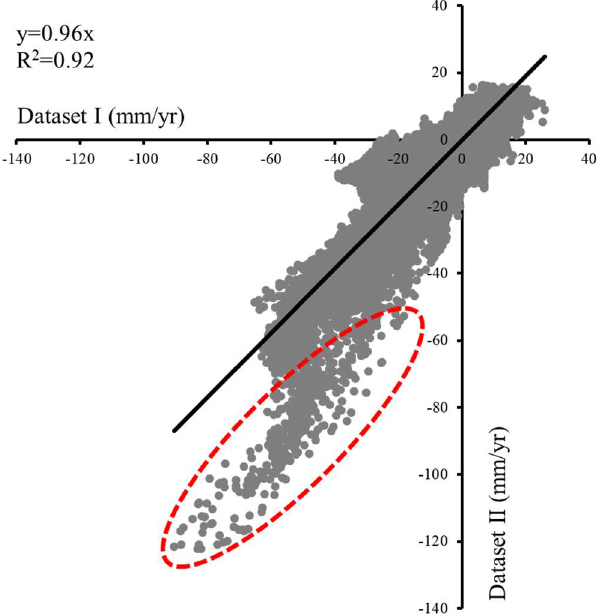
Figure 7. Cross-validation plot between results from datasets acquired by adjacent orbits. The black line is the fitting line of the linear regression and its mathematical expression is given in the upper left of the figure. The outliers of the linear regression are circled by the red dashed ellipse, and they were not removed in the fit.